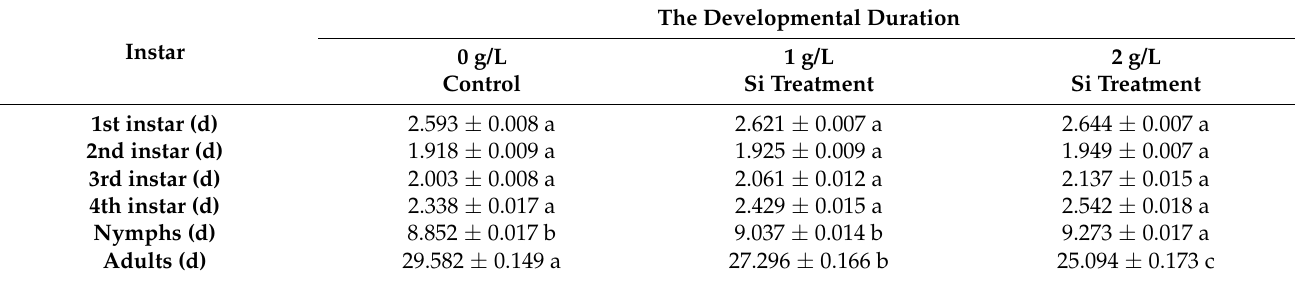
Table 1. Effects of silicon treatments on the developmental period of S. avenae .